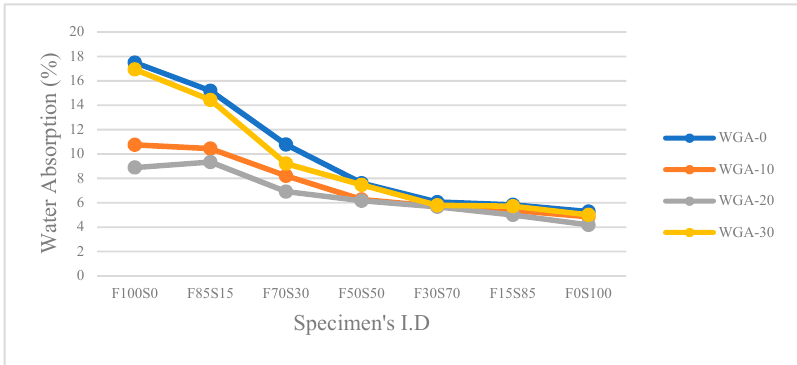
Figure 8. Water absorption of WGA-activated FA/GGBS samples